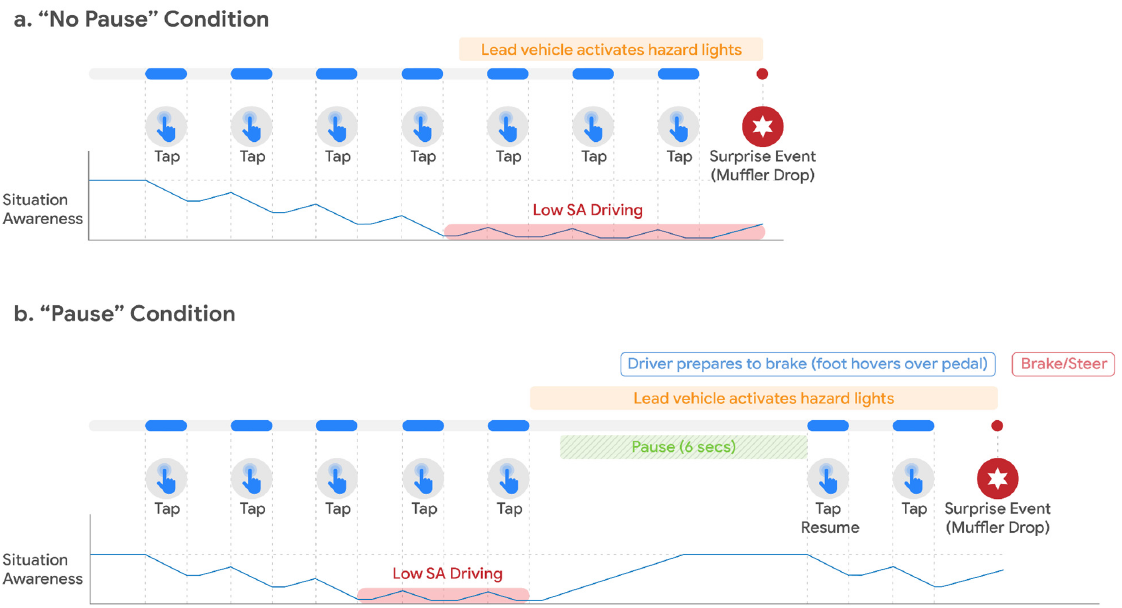
Figure 4. Comparison of drivers’ hypothesized situation awareness between the “No Pause” and “Pause” conditions. ( a ) Plots the hypothesized situation awareness over time as the driver taps on the display in the “No Pause” condition. It was hypothesized that driver’s situation awareness drops to zero during the task. ( b ) Plots the hypothesized situation awareness over time as the driver taps on the display in the “Pause” condition. It was hypothesized that pausing mid-task to look back at the road might reduce the amount of time spent driving with low situation awareness and lead to a higher level of situation awareness at the end of the task.